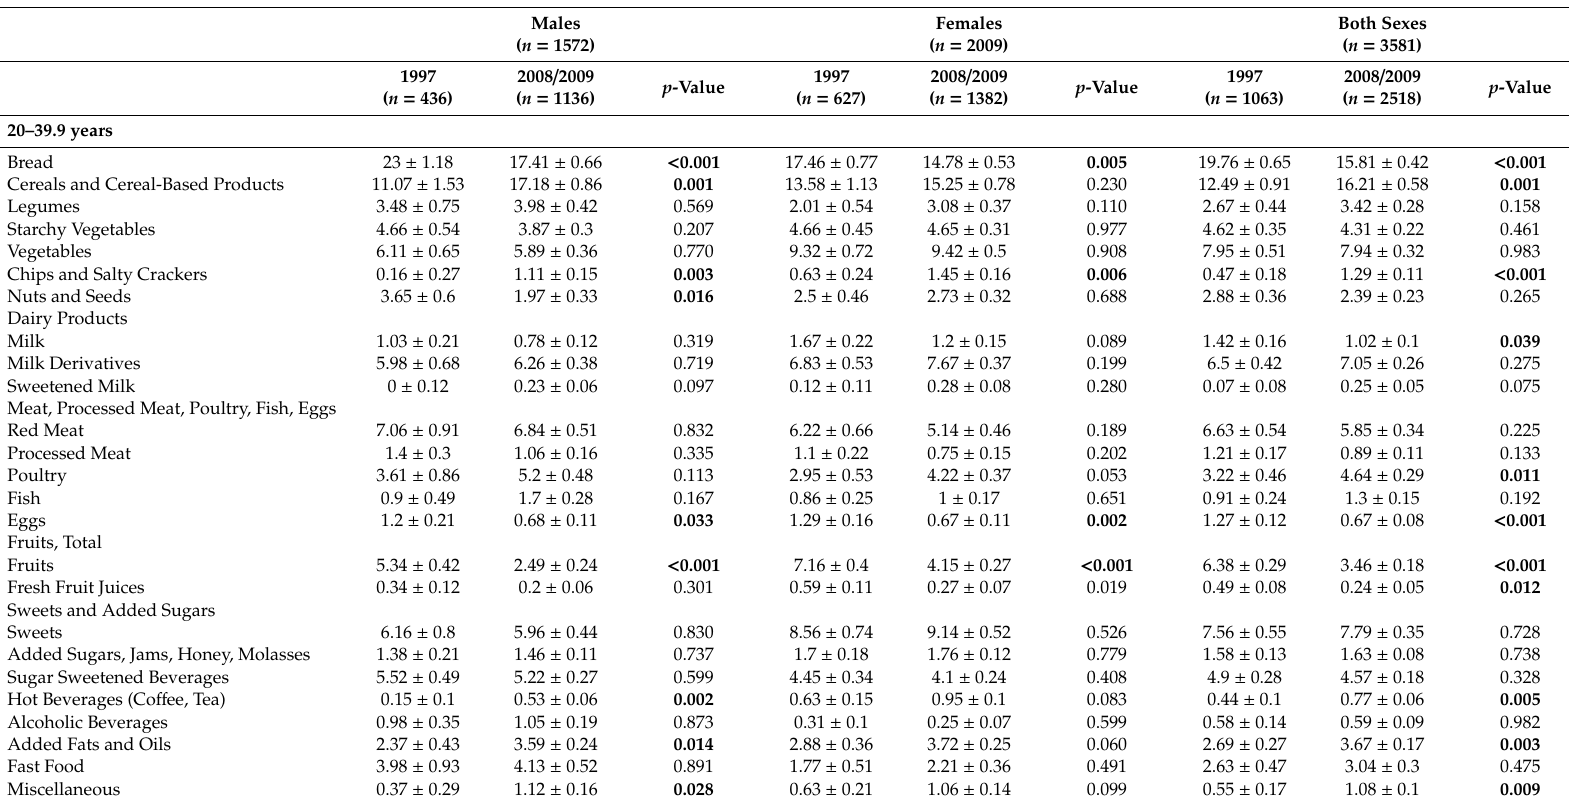
Table 2. Mean daily intake of various food groups (%EI) (by age and sex) and their comparison between 1997 and 2008 / 2009, in the study population ( n = 3581), aged ≥ 20 years,